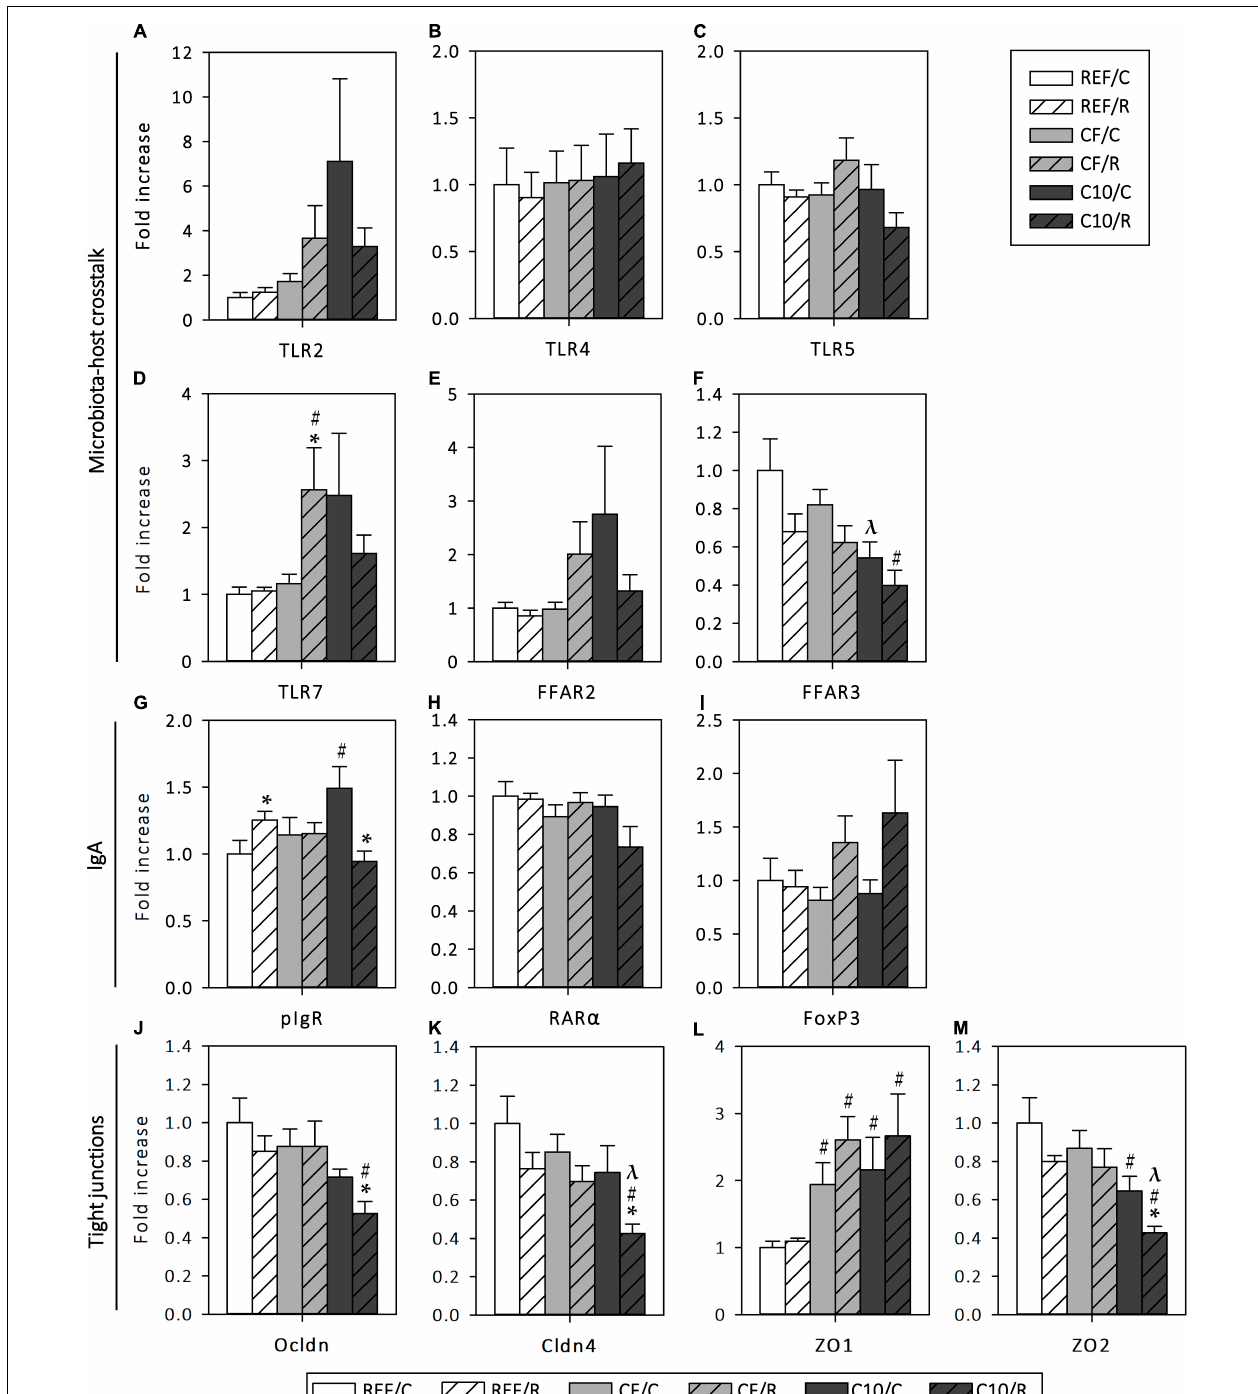
FIGURE 9 | Changes in small intestine gene expression: Toll-like receptor (TLR) 2 (A) , TLR4 (B) , TLR5 (C) , TLR7 (D) , free fatty acid receptor (FFAR) 2 (E) and FFAR3 (F) , polymeric immunoglobulin receptor (pIgR) (G) , retinoic acid receptor (RAR) α (H) , forkhead box P3 (FoxP3) (I) ; occludin (Ocldn) (J) , claudin-4 (Cldn4) (K) , zonula occludens (ZO) 1 (L) and ZO2 (M) gene expression. Results expressed as fold change with respect to the REF/C group. The control (C) groups are represented by smooth bars and the runner (R) groups by striped bars. REF, reference diet; CF, 5% cocoa fiber-enriched diet; C10, 10% cocoa-enriched diet. Data are expressed as mean ± SEM ( n = 8). Statistical differences (Kruskal-Wallis followed by Dunnet’s test): * p < 0.05 vs. the C group in the same diet; # p < 0.05 vs. the same exercise condition in the REF diet; λ p < 0.05 vs. the same exercise condition in the CF diet.